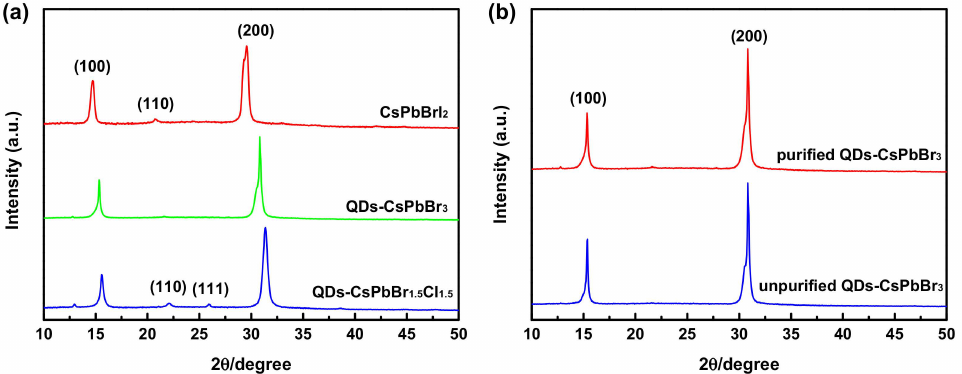
Figure 5. X-ray di ff raction (XRD) patterns of ( a ) single-or double-halide QDs-CsPbX 3 films; ( b ) unpurified and purified QDs-CsPbBr 3